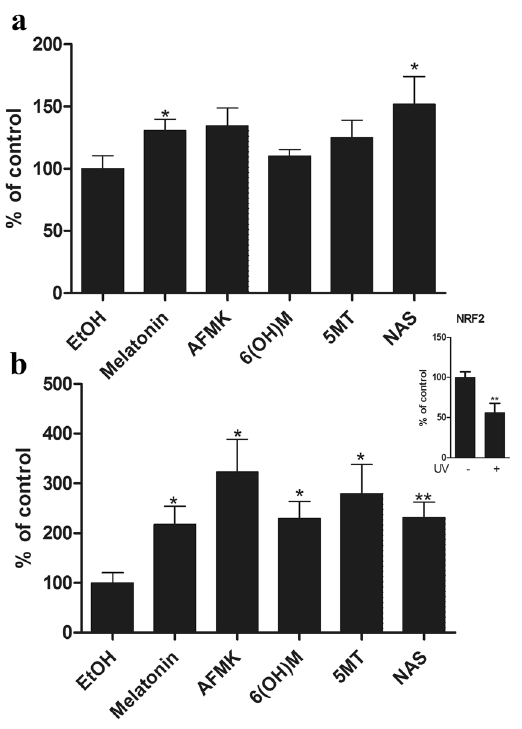
Figure 7. Melatonin, NAS, 6-OHM, AFMK, and 5-MT treated melanocytes increased NRF2 expression after UVB exposure. Melanocytes were exposed to UVB intensities of 0 or 50 mJ/cm 2 and immediately treated with melatonin or its derivative for 24 h. Cells were further fixed and stained with anti-NRF2 antibody. Stained cells were imaged with a fluorescence microscope, fluorescence intensity was analysed using ImageJ software, and data are analysed using Graph Pad Prizm after 0 mJ/cm 2 ( a ) and 50 mJ/cm 2 ( b ). In addition, UVB diminishes NRF2 expression (insert). Data are presented as percentile of control and were analyzed using t- test, * p < 0.05, ** p <